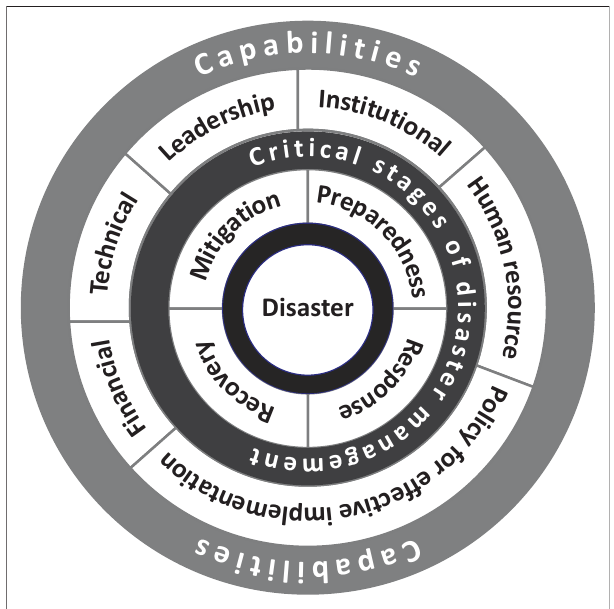
FIG URE 1 : Local government capability in managing natural hazards.